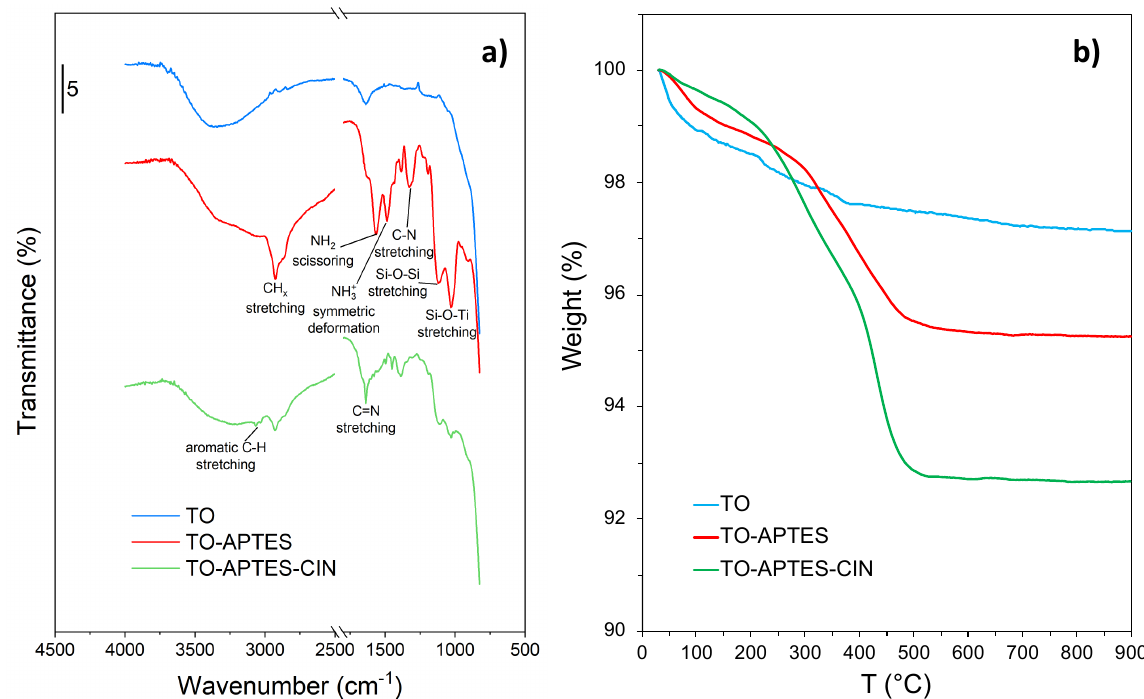
Figure 2. ( a ) FTIR spectra and ( b ) TG analyses of TO, TO-APTES, and TO-APTES-CIN.